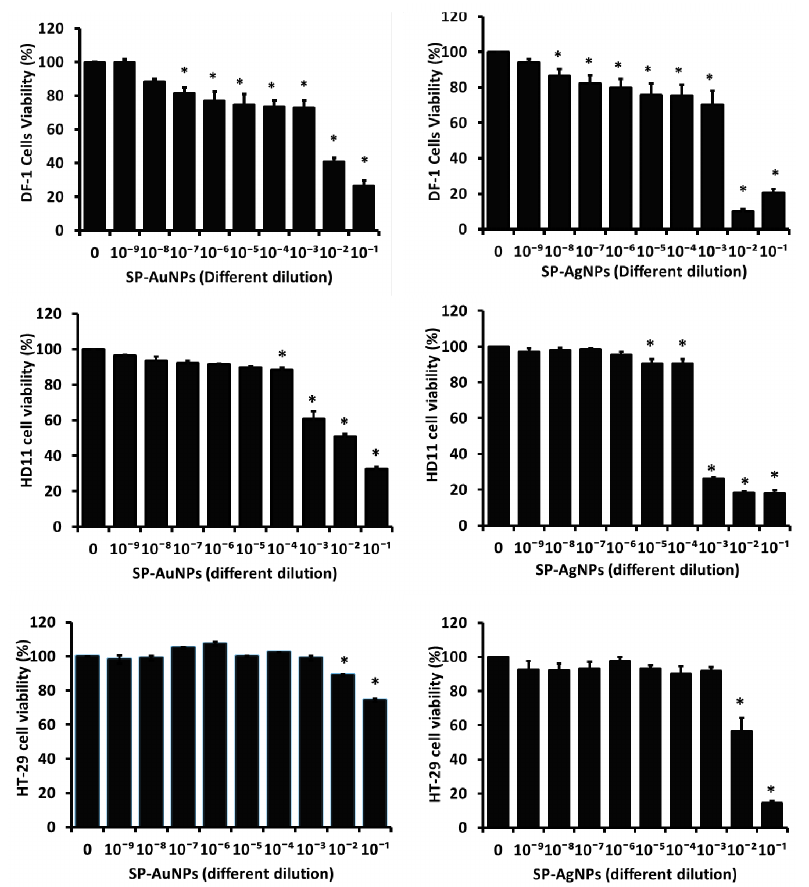
Figure 7. Cytotoxicity of SP-AuNPs and SP-AgNPs in chicken fibroblasts (DF-1), chicken macrophages (HD11), and human colon cancer cells (HT-29) at 24 h as determined using the WST-1 cell viability assay. Experiments were performed in triplicate. (*) − Values are presented as mean ± SE. p < 0.005 was considered statistically significant compared with the control, as calculated by one-way ANOVA and Duncan’s multiple post hoc test ( . Stock concentration: 10 mg·mL − 1 ; 0: control (no NPs), 10 − 1 dilution: 1 mg·mL − 1 ; 10 − 9 dilution: 10 fg·mL − 1